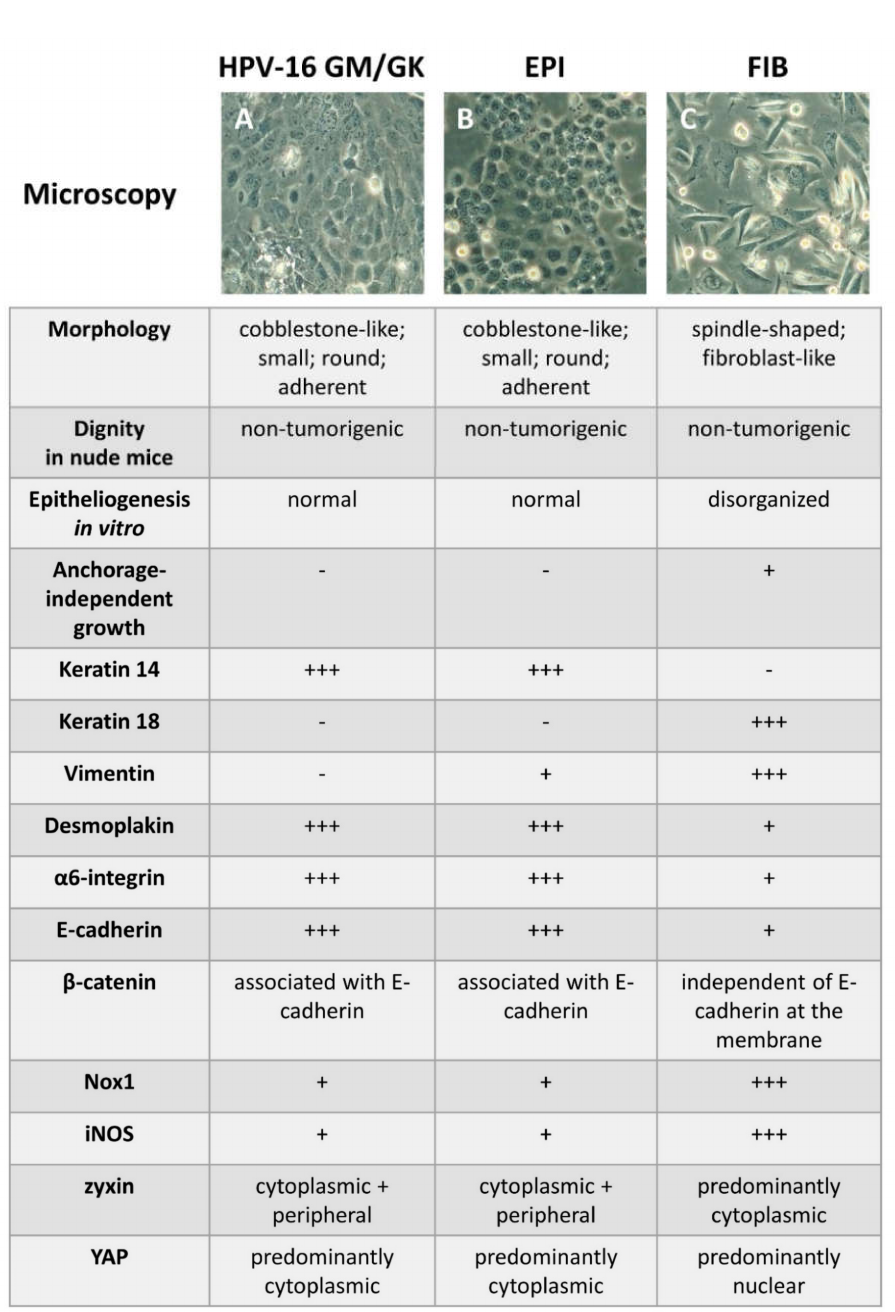
Figure 1. Summary of the morphological and molecular properties of HPV-16 GM (=GK), and the alcohol-treated cell lines EPI (epitheloid) and FIB (fibro-blastoid). The upper part of the figure depicts exemplary light microscopy pictures of the cell lines at the same magnification. ( A ) shows the GKs with their cobblestone morphology, which is typical for keratinocytes. ( B ) depicts EPI cells, which share morphological similarities with GKs but show more cytoplasmic inclusions and more pronounced nuclei. In ( C ), the fibroblast-like, spindle-shaped FIB cells are presented. When compared to GKs and EPI, FIB cells do not resemble normal keratinocytes and are characterized by multidirectional cytoplasmic extensions and a less dense growth pattern. The lower part of the figure summarizes the main cell behavioral and molecular properties of the three cell lines. The protein expression levels are designated as follows: +++ very strong expression, + strong expression, - no expression. Details are given in the main text. (Nox1 = NADPH Oxidase 1; iNOS = inducible Nitric Oxide Synthase; YAP = Yes-Associated